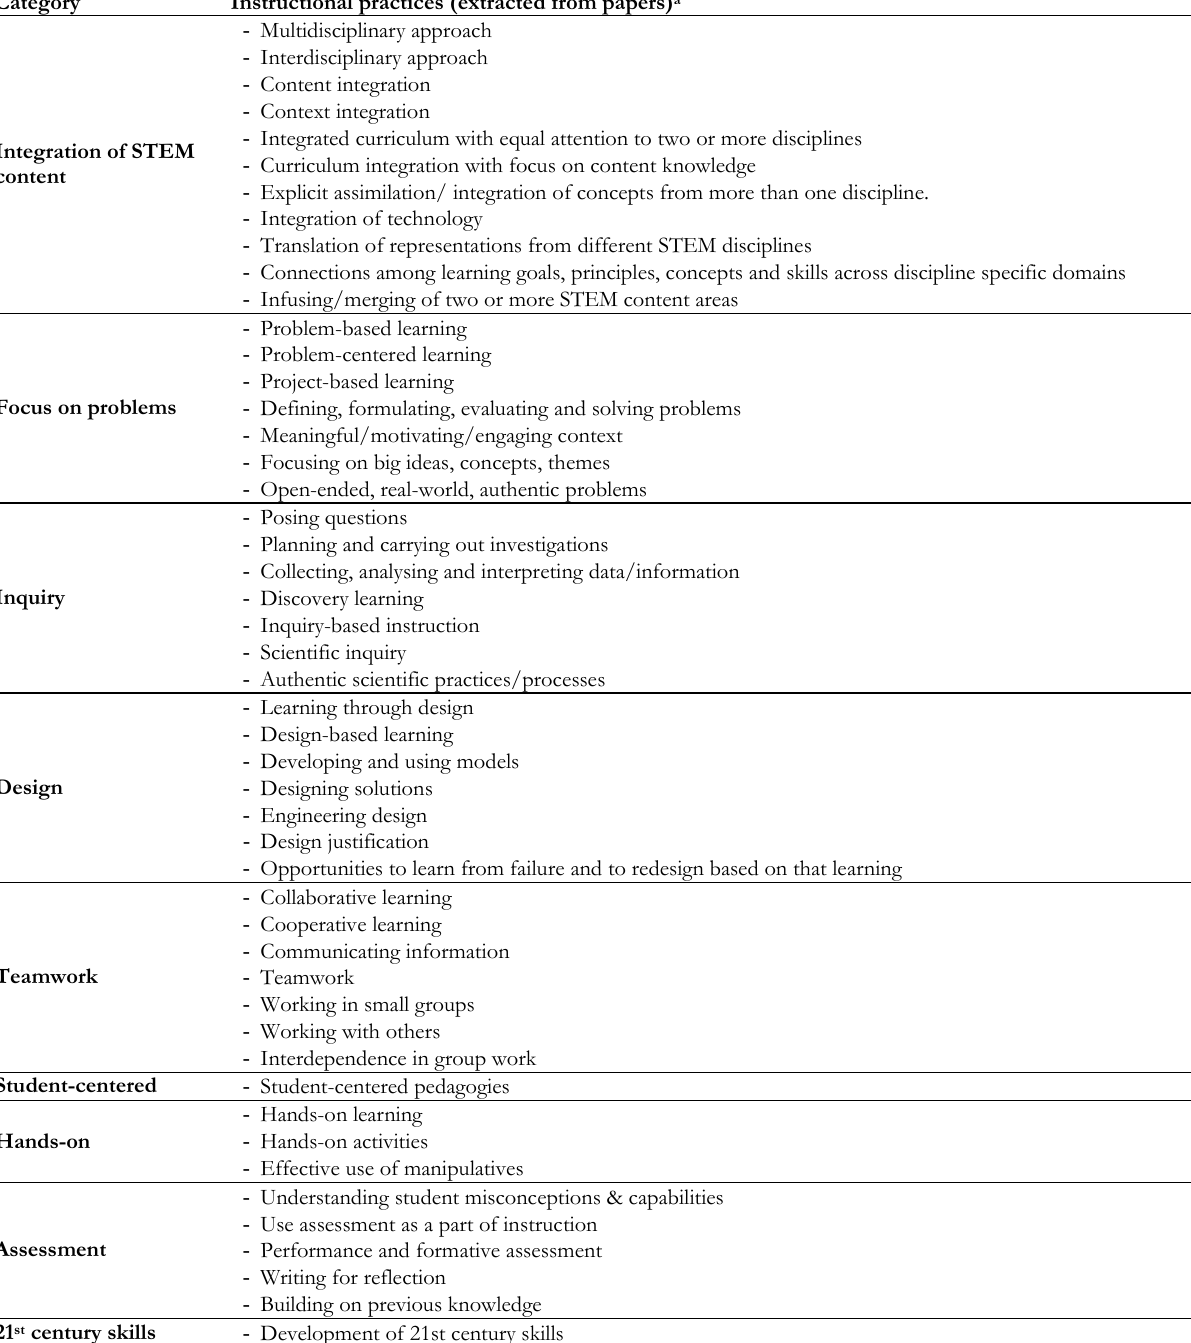
Table 1. Overview of the instructional practices from all papers, arranged in nine categories